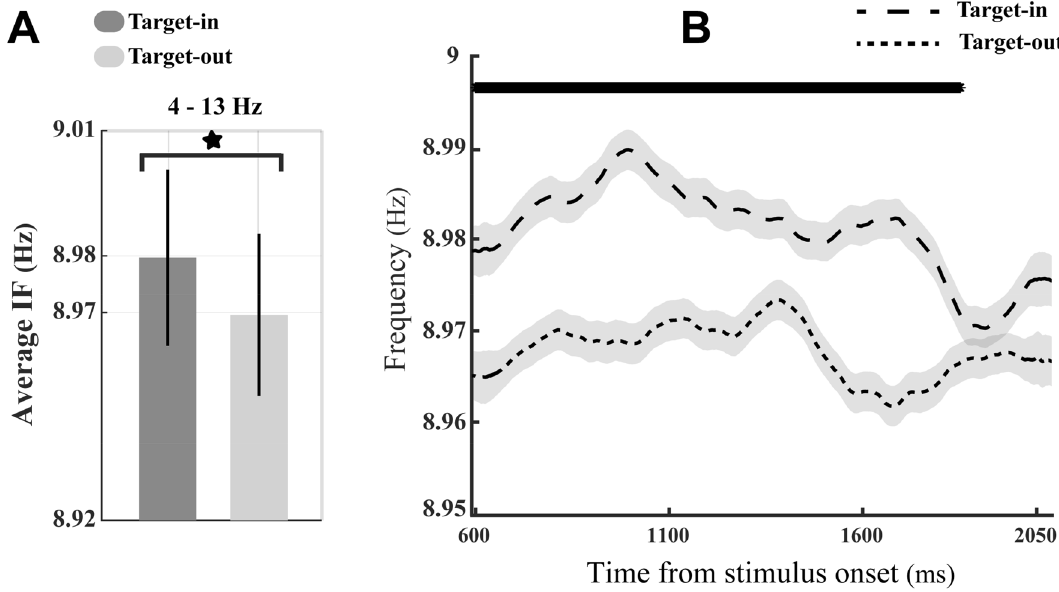
Figure 3. Modulation of the theta–alpha IF in trials with a resembling SNR. ( A ) The average IF of neurons at the target-in (the dark bar) and the target-out (the light bar) conditions. Despite estimating the IF in the frequency range of 4–13 Hz, the Y-axis was manually adjusted to provide the best illustration of the significant difference between light and dark bars. The asterisk demonstrates a significant difference in the average IF between the two task conditions ( p < 1.3 × 10 −7 , two-sided sign-test). Error bars show the ± 1 STD. ( B ) The temporal variation of the theta–alpha frequency during the stimulus presentation period. The thick-black line indicates a time window with a significant discrepancy in the IF of neurons between the two task conditions ( p < 0.008, two-sided Wilcoxon rank-sum test with FDR correction for multiple comparisons).